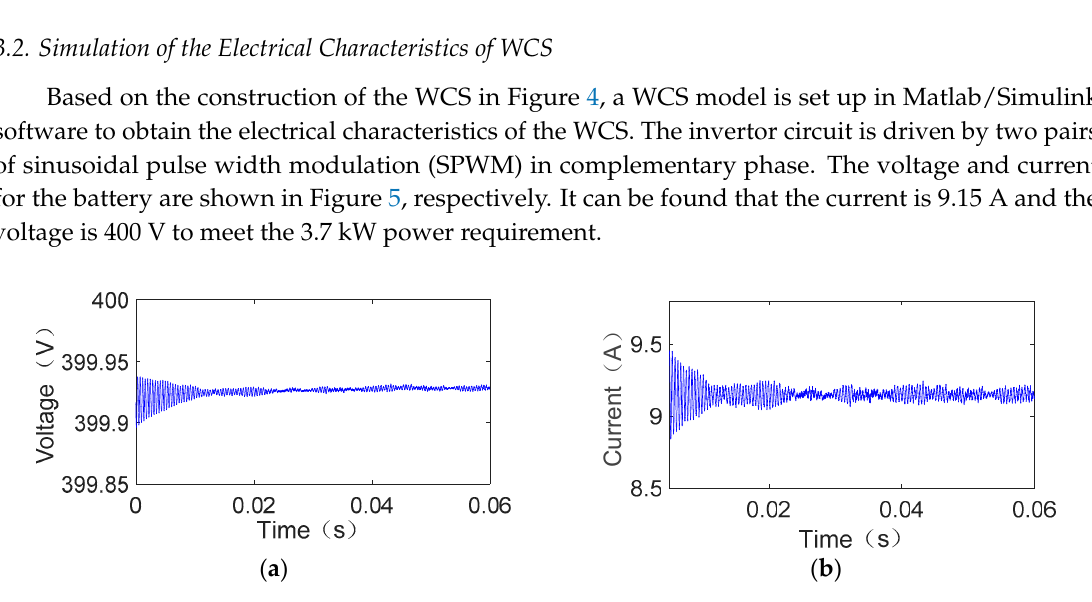
Figure 5. WCS functional simulation results ( a ) Charging current; ( b ) Charging voltage.